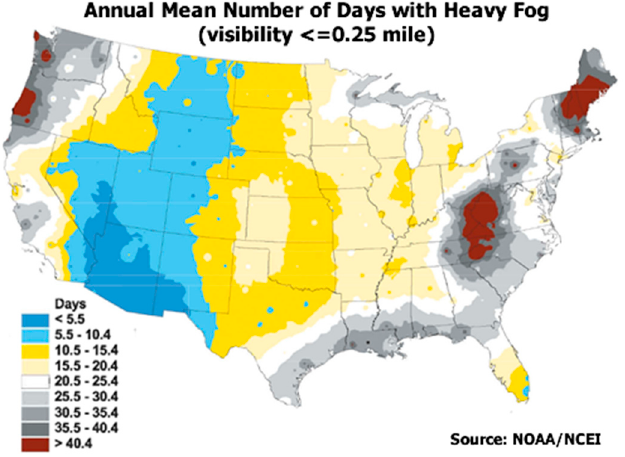
Figure 1. Annual mean number of days with heavy fog over the continental United States [10].